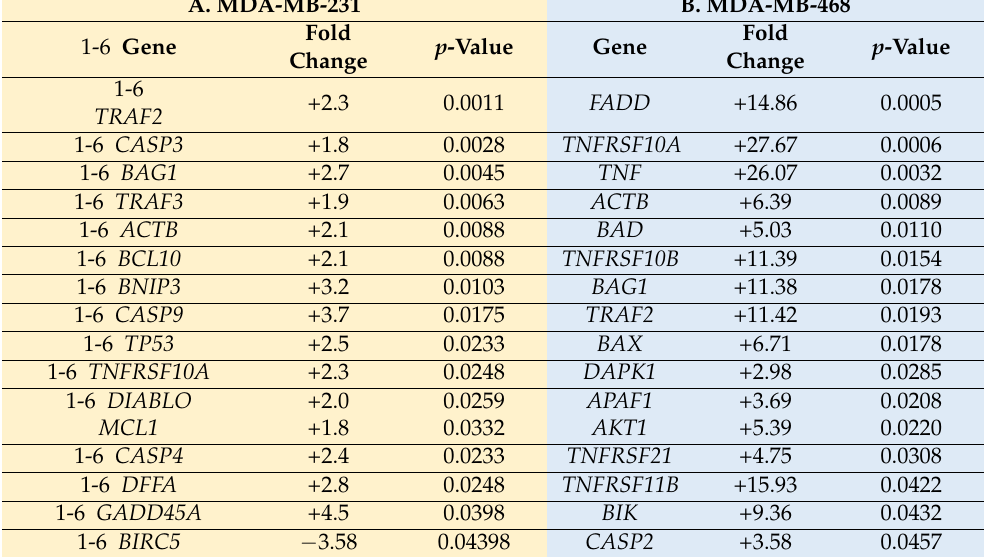
Table 3. A comparative illustration of thymoquinone (TQ) effects on mRNA gene expression